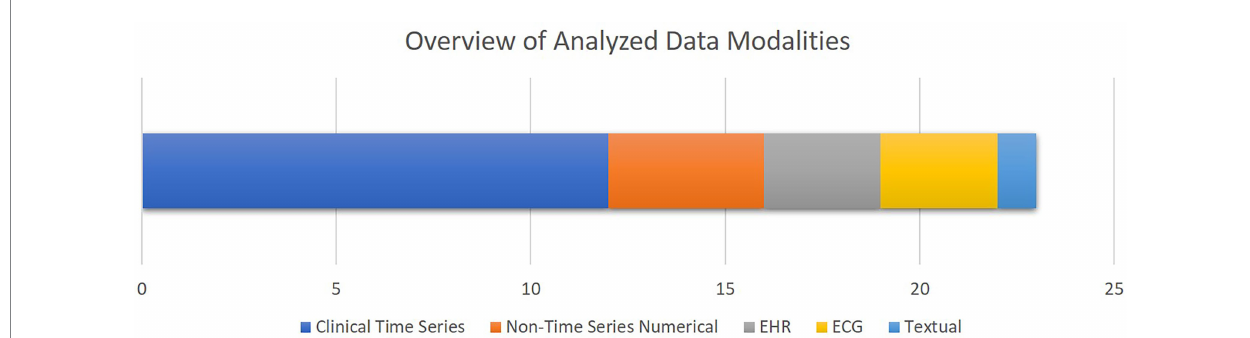
FIGURE 5 The overview of the data modalities analyzed in the selected studies. The bar chart shows how frequent each data modality has been, with the X axis quantifying the number of studies. Note that some studies analyzed multiple data modalities.